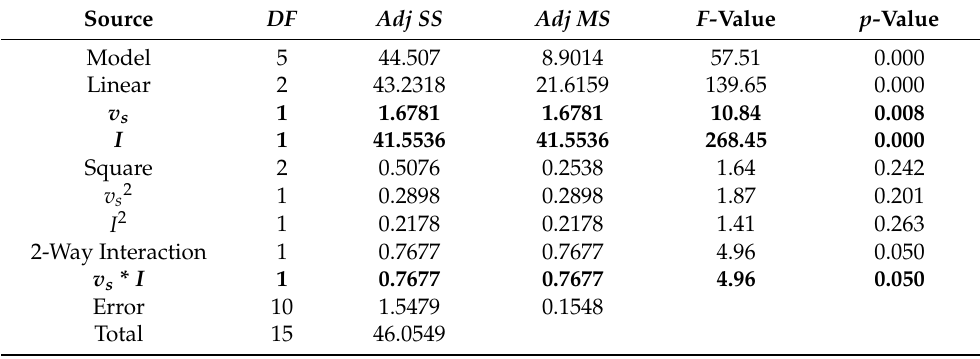
Table 5. ANOVA for the surface roughness ( Ra ). Significant regression coefficients are listed in bold typeface.